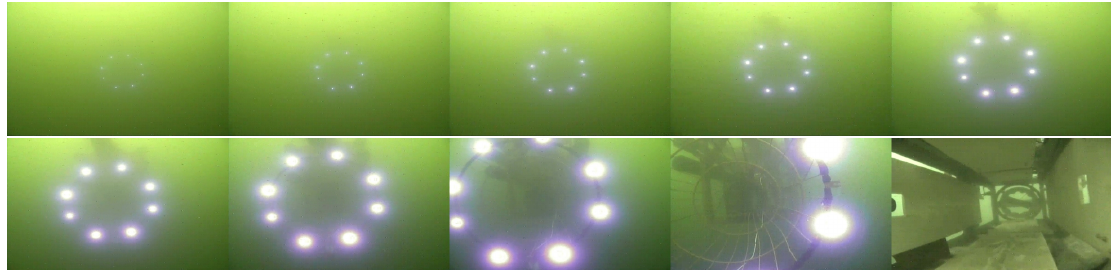
Figure 14. Images of the recycling process of Run